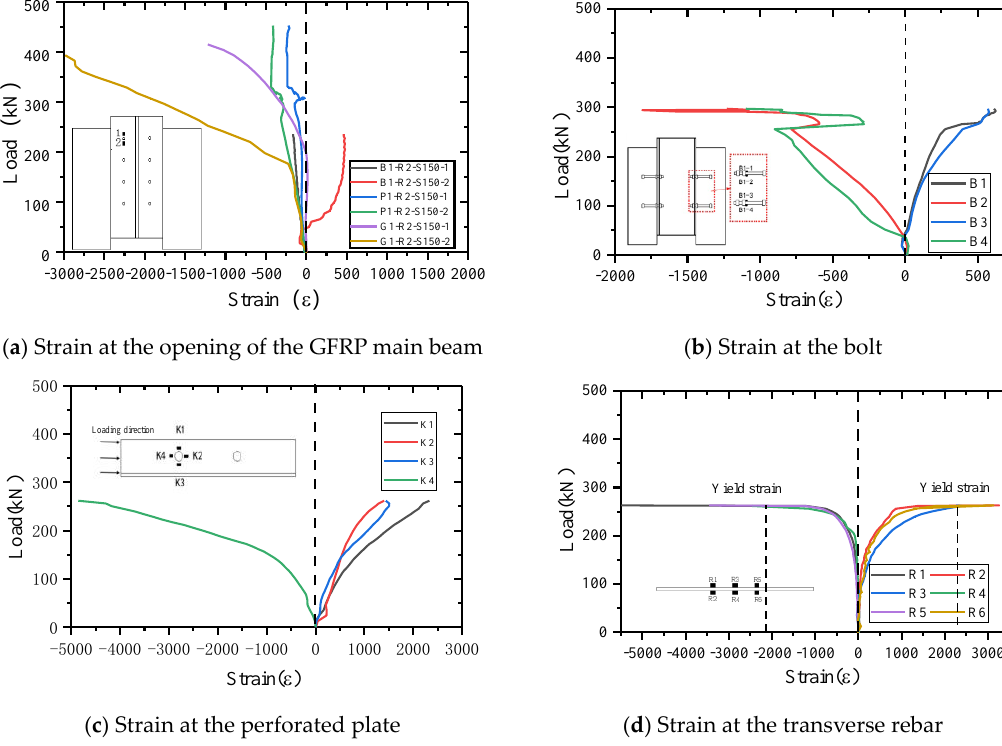
Figure 11. Load versus longitudinal strain curves.